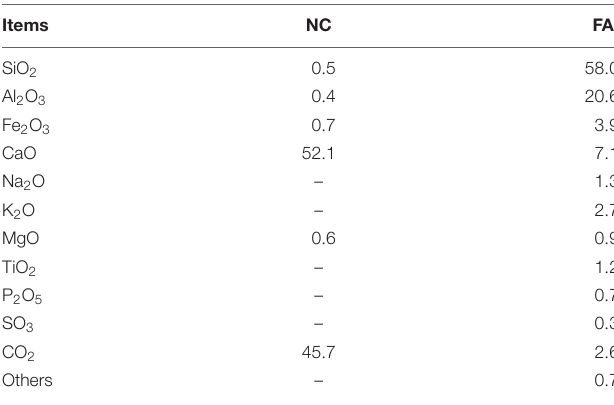
TABLE 1 | Chemical composition of nano-CaCO 3 (NC) and fly ash (FA) (by